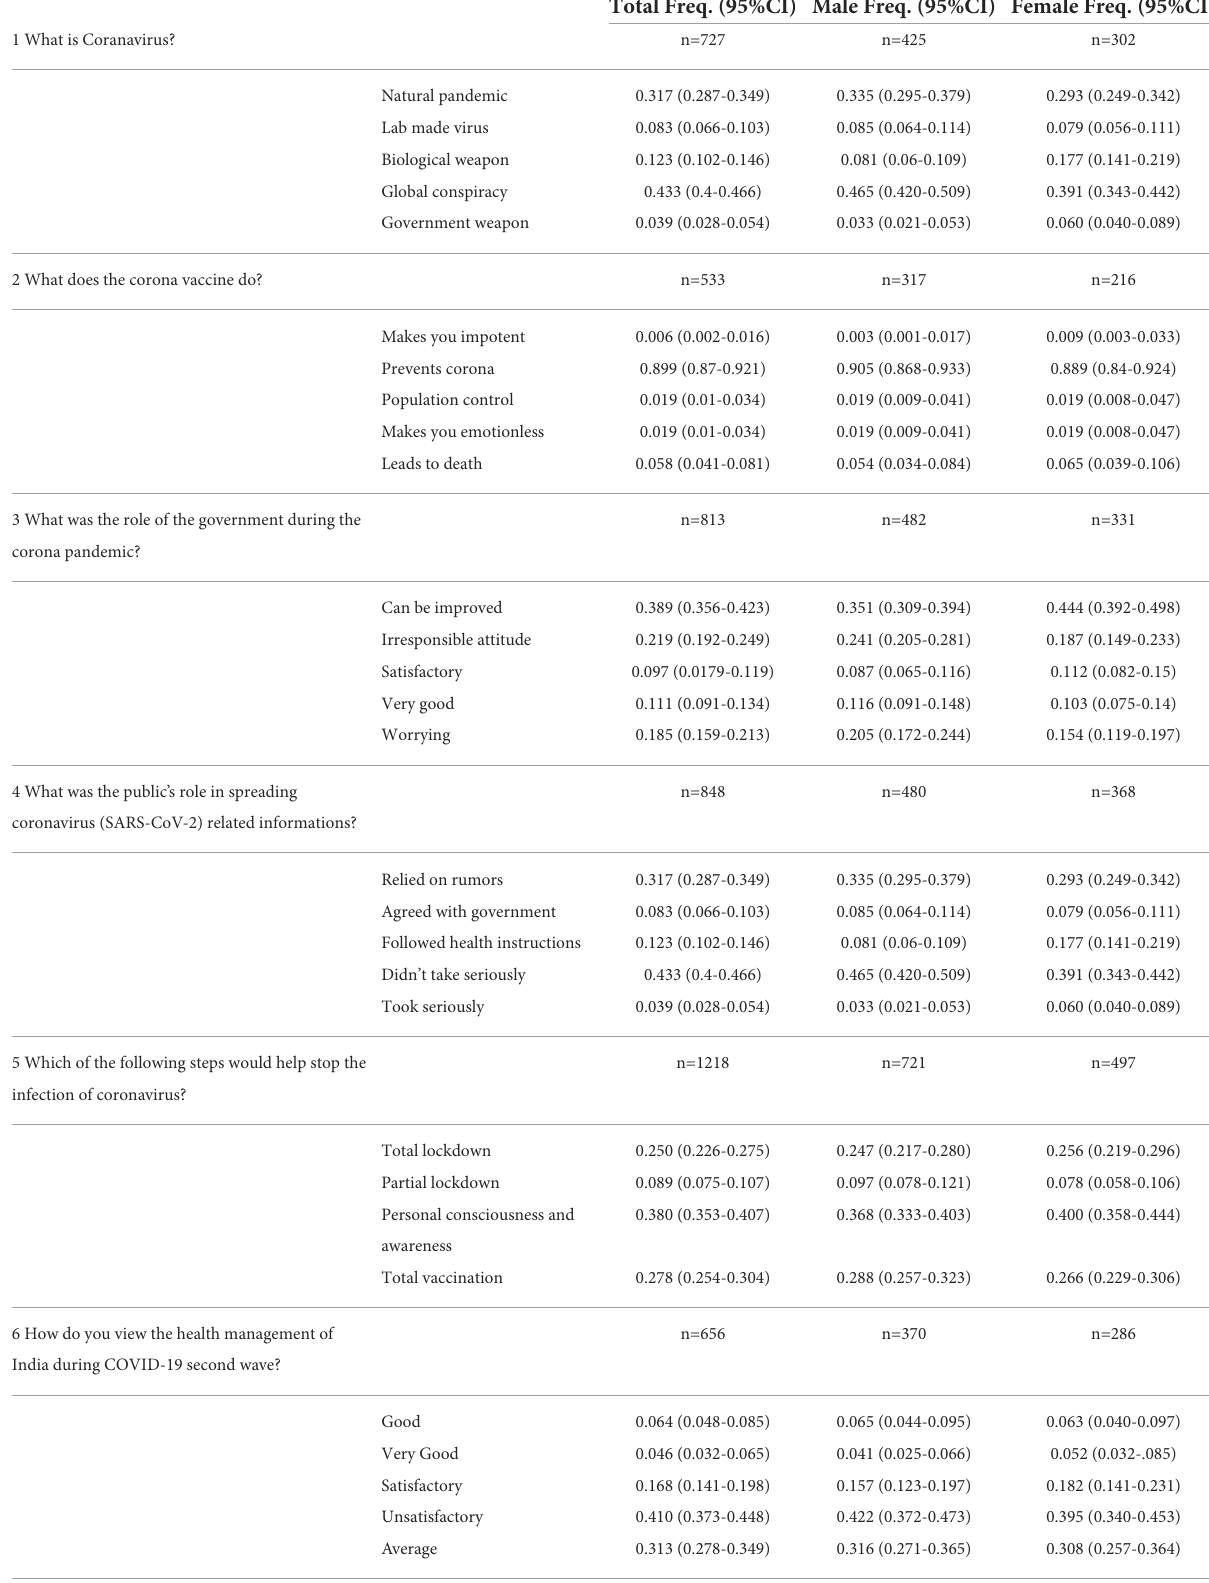
TABLE 1 Respondents frequency (with 95% CI) on multiple choice questions investigated during the survey; n = number of